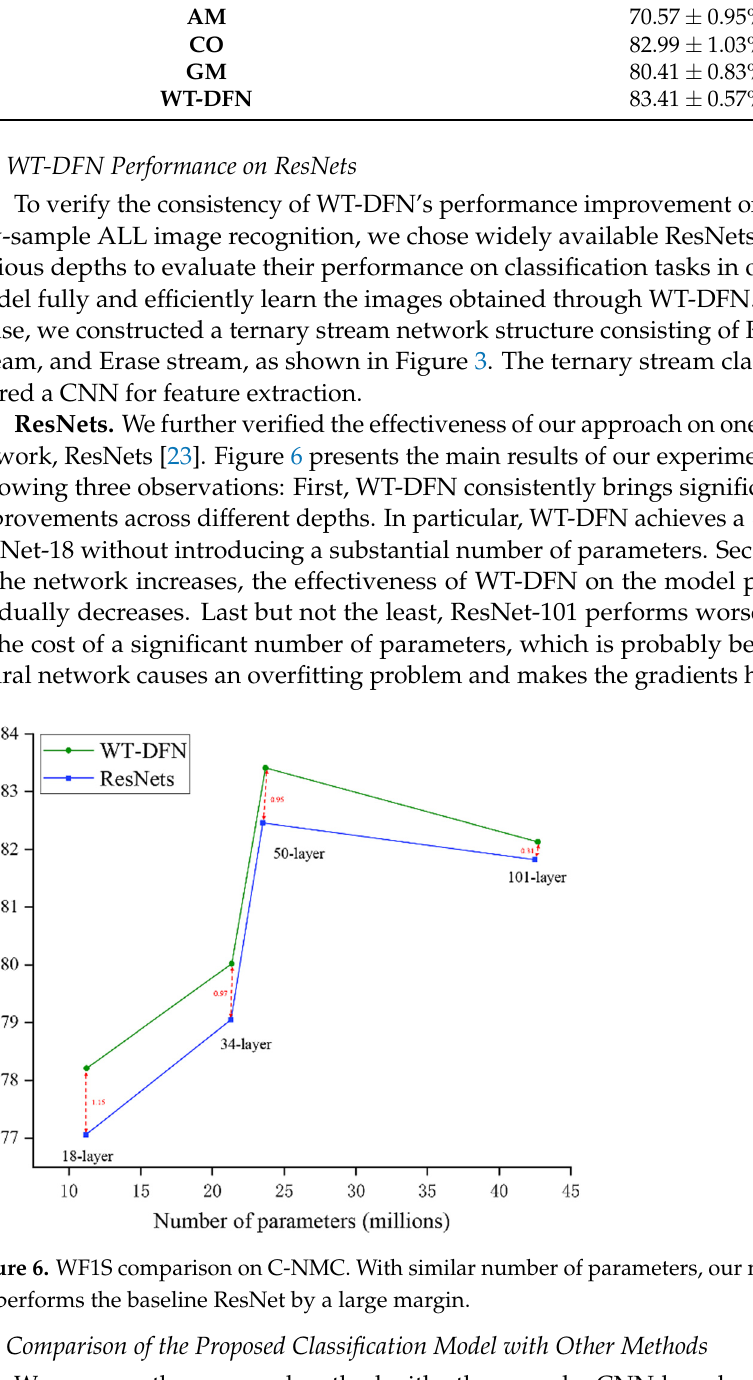
Table 1. Comparisons with state-of-the-art augmentation methods on C-NMC.